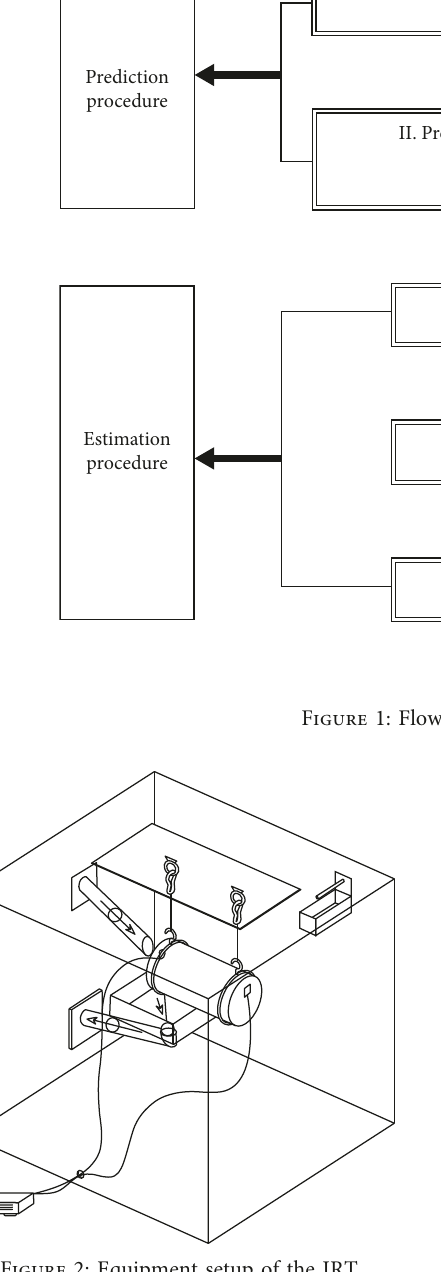
Figure 2: Equipment setup of the